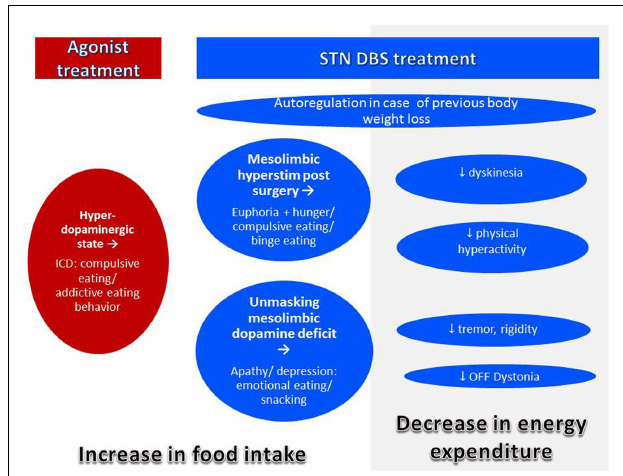
FIGURE 3 | Mechanisms of body weight gain in PD . Body weight gain may occur with treatment by agonist or DBS. Both agonist and DBS treatment may lead to modifications of eating behavior leading to increased food intake. In addition, with successful DBS treatment, energy expenditure decreases by improvement of symptoms leading to body weight gain even in the absence of eating